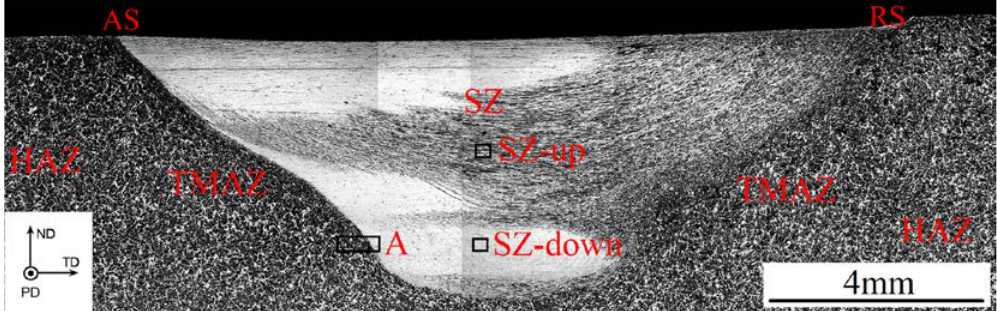
Figure 3. Optical macrostructure of a cross-section of the FSP Mg–6Sn–2Zn sample at the travel speed of 60 mm/min.